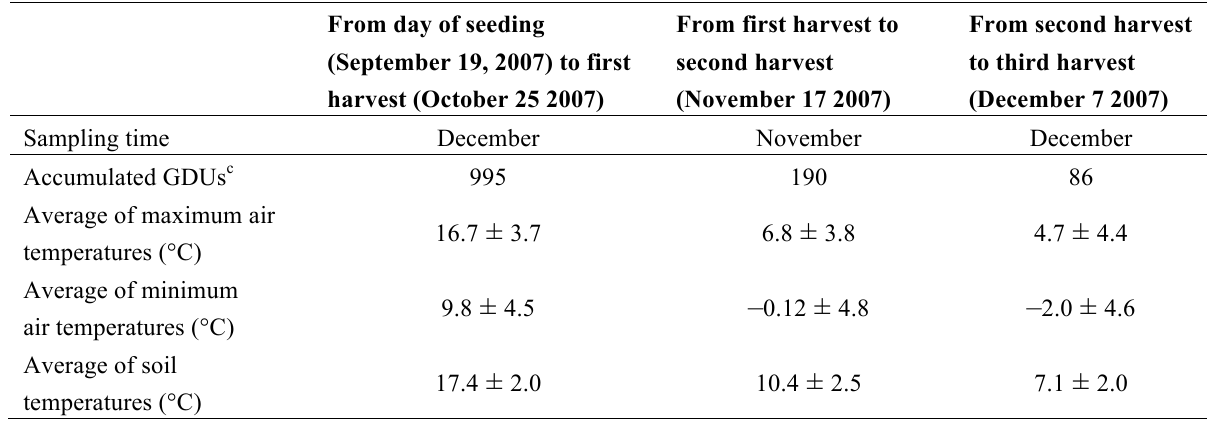
Table 2. Environmental conditions recorded at the Virginia Tech Kentland Research Farm from seeding to the last harvest.